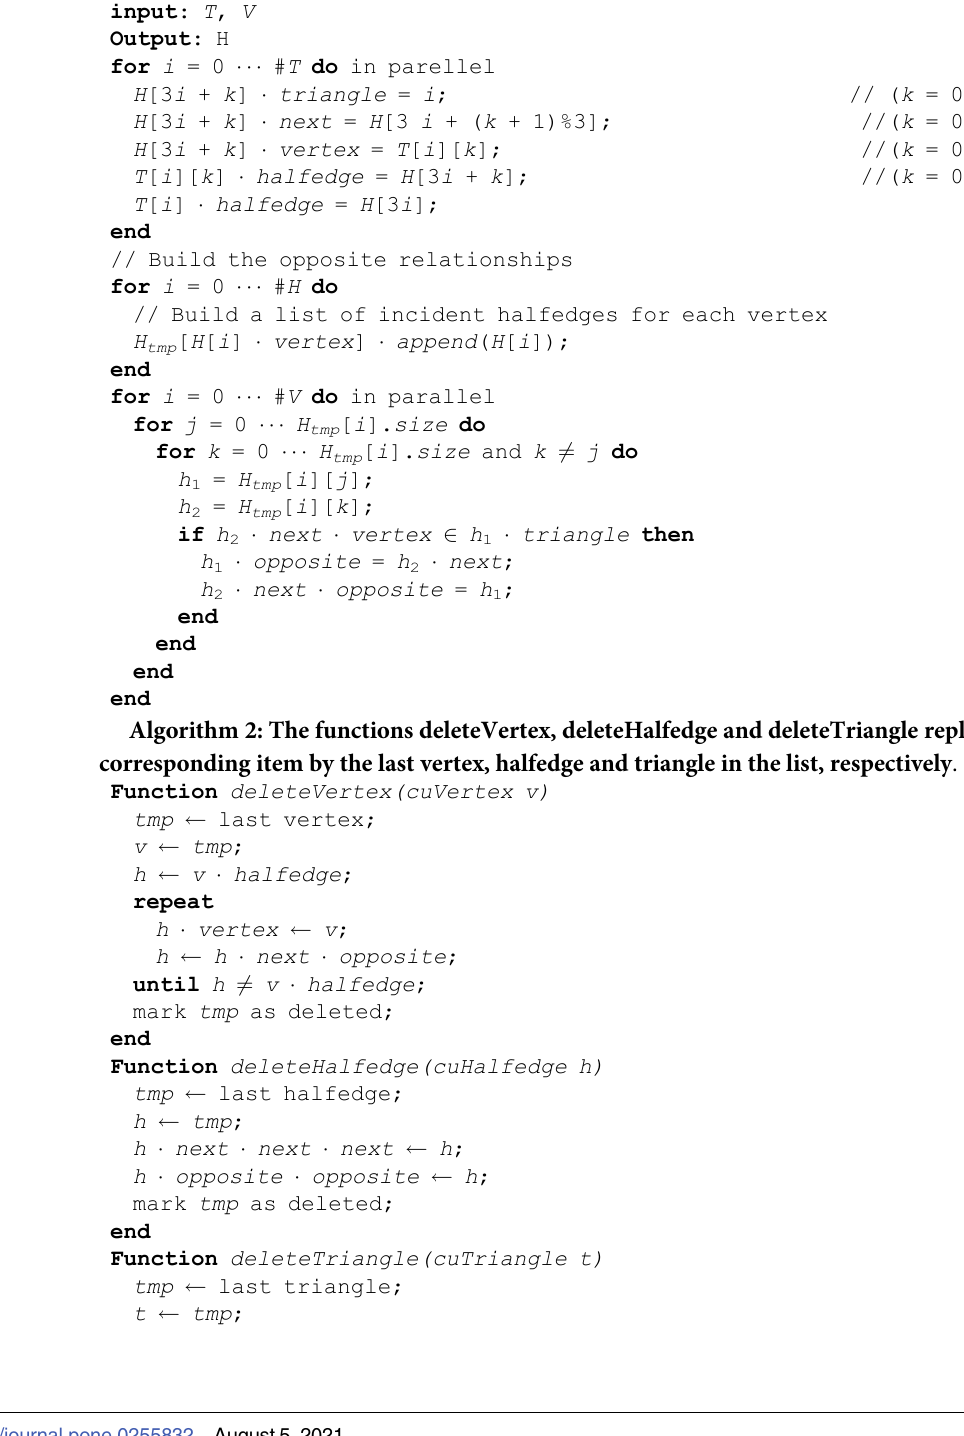
Algorithm 1: Build the data structure .